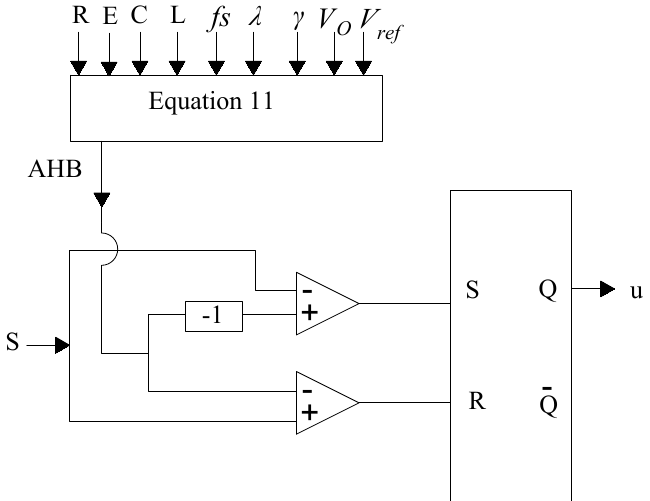
Figure 16. Adaptive hysteresis band with flip-flop.